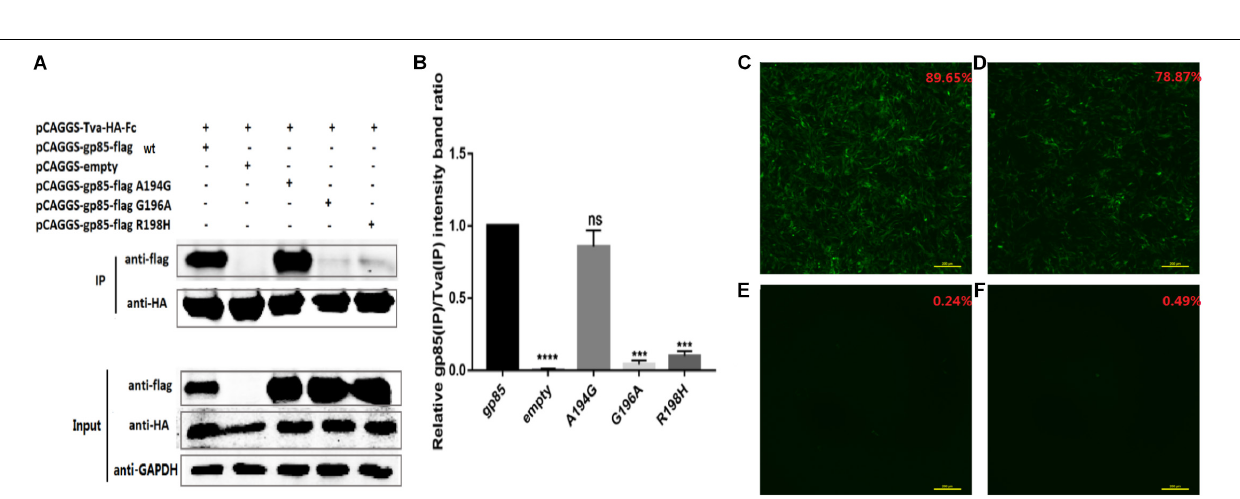
FIGURE 7 | Single amino acid mutation, G196A and R198H, terminated the replication ability of the recombinant virus. (A) The interaction of individual amino acid substitution (A194G, G196A, and R198H) in soluble chimeric protein gp85-flag s2 with Tva-HA-Fc, for which the proteins were immunoblotted with anti-flag or anti-HA mAb. (B) The level of protein was quantified using Image StudioLiteVer 5.2, and soluble chimeric proteins gp85-flag (IP)/Tva-HA-Fc (IP) were calculated. (C) The fluorescence signal of recombinant virus RCASBPGDFX0602-EGFP and the percentage of GFP-positive cells are shown in the upper right corner of each image. (D) The fluorescence signal of recombinant virus RCASBPGDFX0602 A194G-EGFP. (E) The fluorescence signal of recombinant virus RCASBPGDFX0602 G196A-EGFP. (F) The fluorescence signal of recombinant virus RCASBPGDFX0602 R198H-EGFP. Three independent experiments were performed, and data are shown as mean ± SD in triplicate from a representative experiment. Statistical analysis (two-way analysis of variance) was performed using GraphPad Prism 7; *** P < 0.001, **** P < 0.0001, ns P > 0.05.